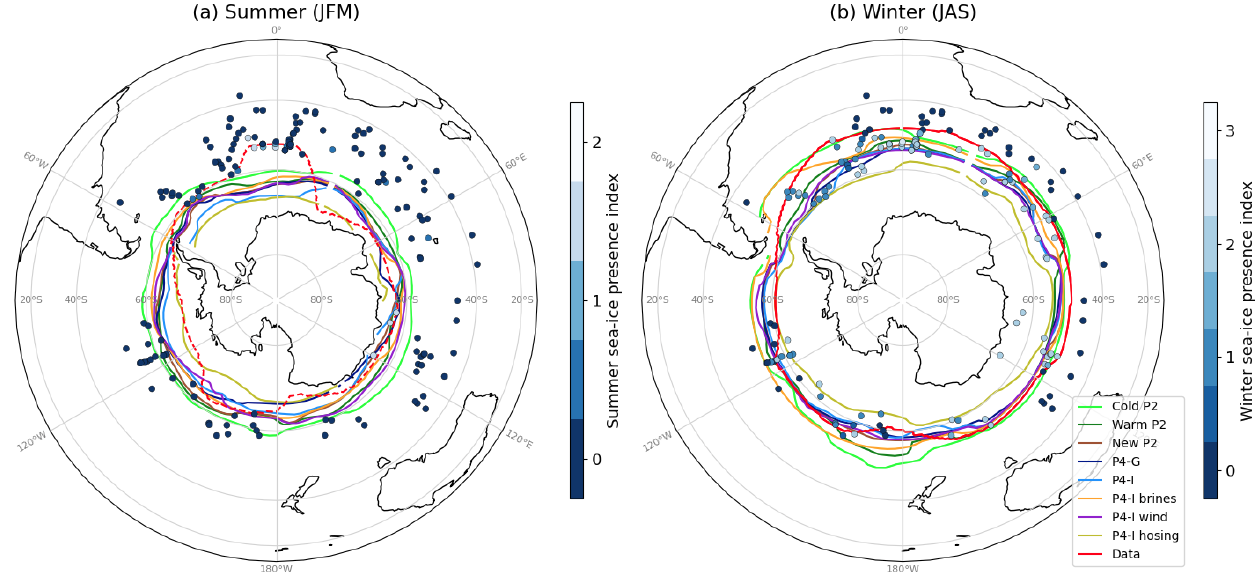
Figure 6. Austral summer (a) and winter (b) sea-ice edges (at 15% of sea-ice concentration, enclosing the total ocean surface defined as the sea-ice extent) in the Southern Ocean for the LGM simulations. The sea-ice presence suggested by marine core data is represented as an arbitrary index on a blue to white scale, where blue denotes no indication of sea ice in proxies, and white denotes agreement of several proxies on the presence of sea ice. The red lines mark the likely delimitation of the sea-ice presence according to the proxy data (compilation of data from Gersonde et al., 2005; Allen et al., 2011; Ferry et al., 2015; Benz et al., 2016; Xiao et al., 2016; Nair et al., 2019; and Ghadi et al., 2020). We used a solid red line in panel (b) but a dashed line in panel (a) as the summer contour is not well constrained (see Sect.